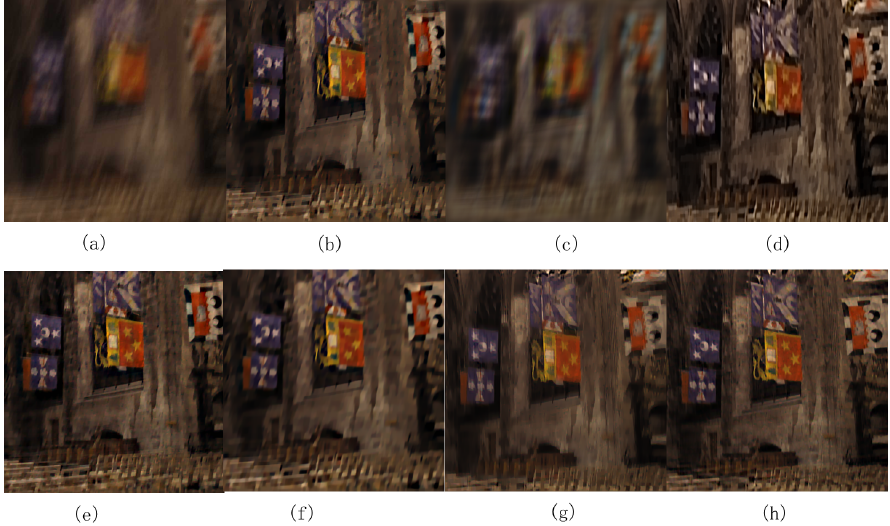
Figure 2. Visual comparison of the results using one challenging image from dataset [44]. The image ( a ) is blurry input; ( b – h ) are deblurring results of Ref. [21], Ref. [27], Ref. [14], Ref. [48], Ref. [18], Ref. [19] and our proposed method,